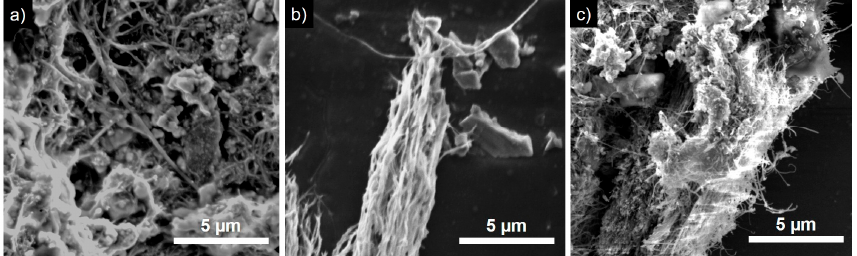
Figure 4. SEM images of DLICVD experiments conducted using a reaction temperature of 800 °C, a 1 mL/h injection rate, a 1.25 wt.% catalyst concentration, using EtOH as a carbon source, and an aspiration temperature of ( a ) 150 °C, ( b ) 225 °C, and ( c ) 300 °C.